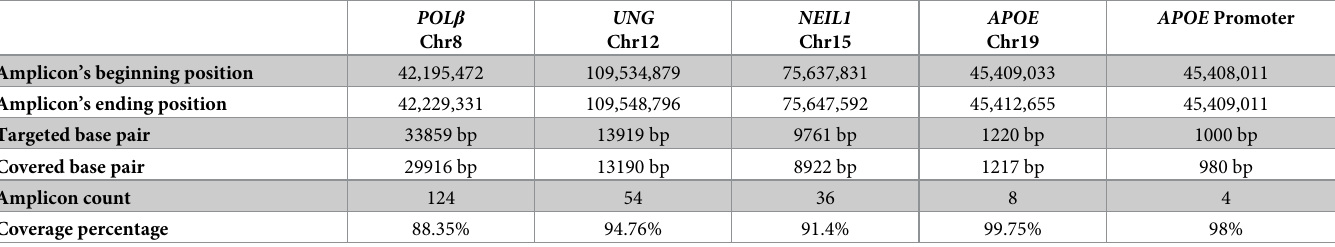
Table 1. The information for the designed Ion PGM primers using Ion Ampliseq Designer